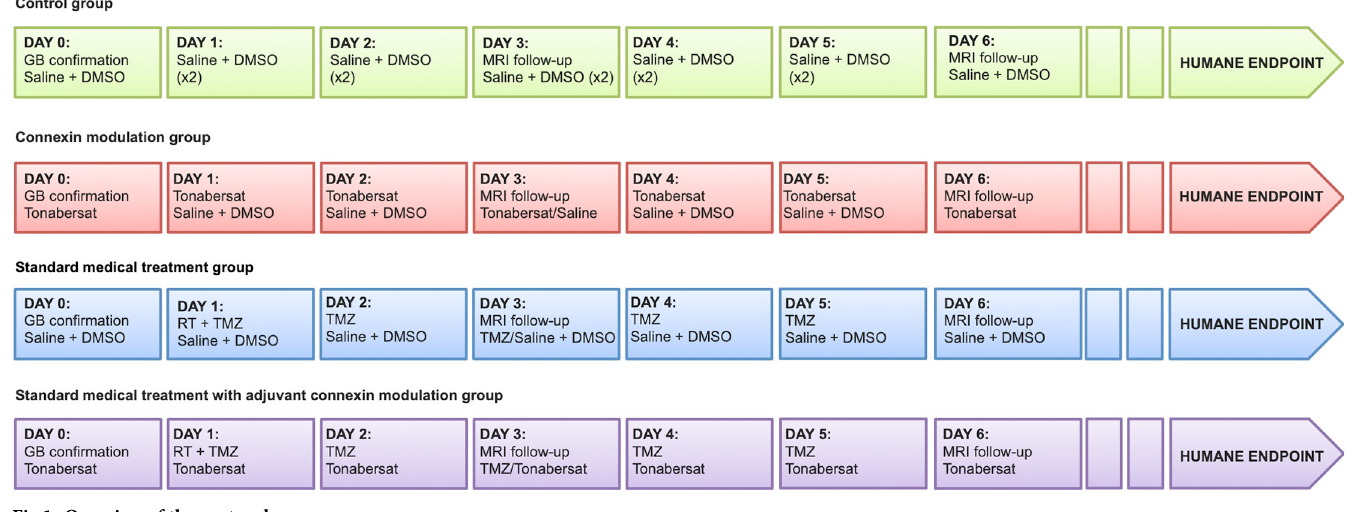
Fig 1. Overview of the protocol per